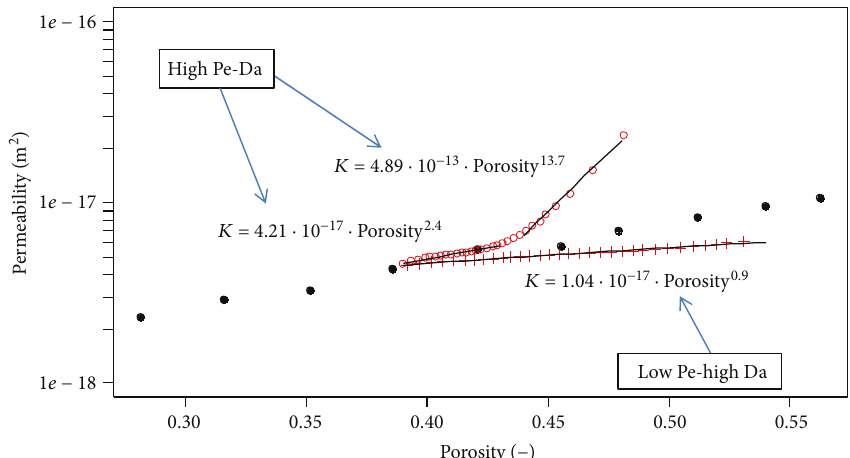
Figure 5: Fitted permeability porosity correlations, describing the evolution of permeability of the pore structure ε = 0 39 , for two di ff erent reactive and fl ow conditions. Open red circles correspond to the evolution under high Pe-high Da conditions and have been fi tted using two correlation functions (black lines). Red solid line and crosses depict the low Pe-high Da case. Black circles represent the permeability of the pristine